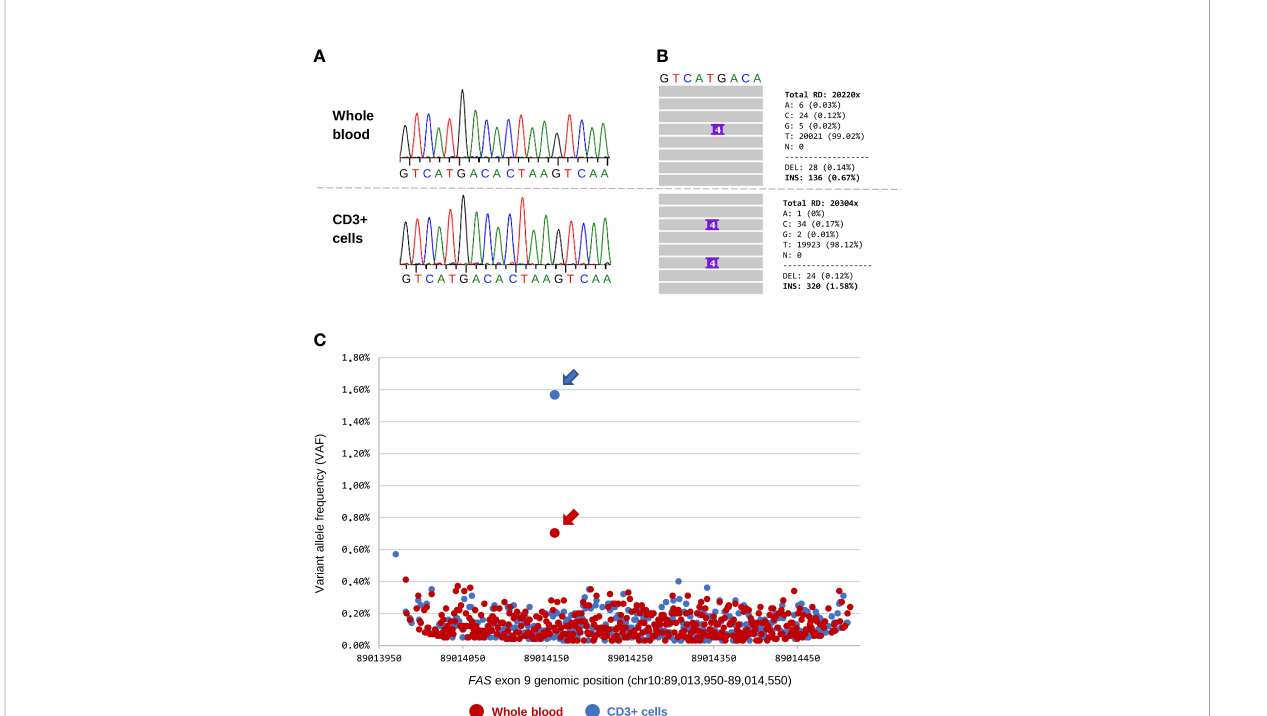
FIGURE 3 Detection of the somatic FAS variant in blood and CD3 + cells. (A) Sanger sequencing of whole blood and CD3 + cells (sample obtained in 2021). DNT count at that time accounted for 0.89% of the total CD3 + lymphocytes. There is no evidence of the somatic variant in chromatograms of the two samples. (B) Details of the deep amplicon sequencing results for the two samples. IGV screenshot and total read counts are shown. (C) Chromosome position and variant allele frequency (VAF) of all presumed somatic variants called by VarScan 2 in exon 9 of the FAS gene (hg38). Each dot is a variant: 470 variants were obtained from whole blood (dots in red) and 450 from CD3 + cells (dots in blue). The pathogenic somatic variant (chr10:89,014,160; c.718_719insGTCG) is indicated with an